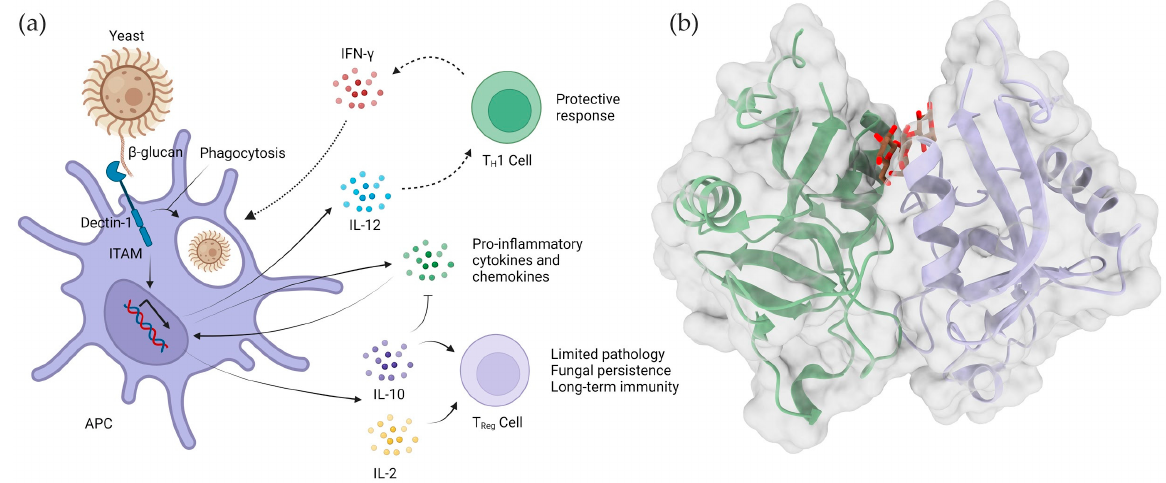
Figure 5. Dectin-1 activation by fungal β -glucans. ( a ) Dectin-1-mediated anti-fungal immunity via β -glucan binding is a consequence of several cellular responses, including fungal uptake and killing [111,112], and the production of pro-inflammatory cytokines and chemokines that lead to immune cell recruitment and activation [113,114]. Dectin-1-mediated recognition also stimulates the production of interleukin-12 (IL-12), which elicits a protective T helper 1 (T h 1)-cell response with the production of interferon- γ (IFN- γ ), thereby activating fungal killing by the phagocytes [113,115]. In dendritic cells, Dectin-1 activation can also induce the production of IL-10 and IL-2 [115], leading to the development of regulatory T cells, which prevent pathological inflammation and promote long-term immunity [116]. IL-10 also inhibits the production of pro-inflammatory cytokines and chemokines (based on a figure by Brown, G. 2006 [117]). Panel ( b ) shows a cartoon representation of the 3D structure of dimer of two Dectin-1 lectin modules (green and blue), with a trapped β -glucan oligosaccharide between the two units, in brown (PDB code: 2cl8).